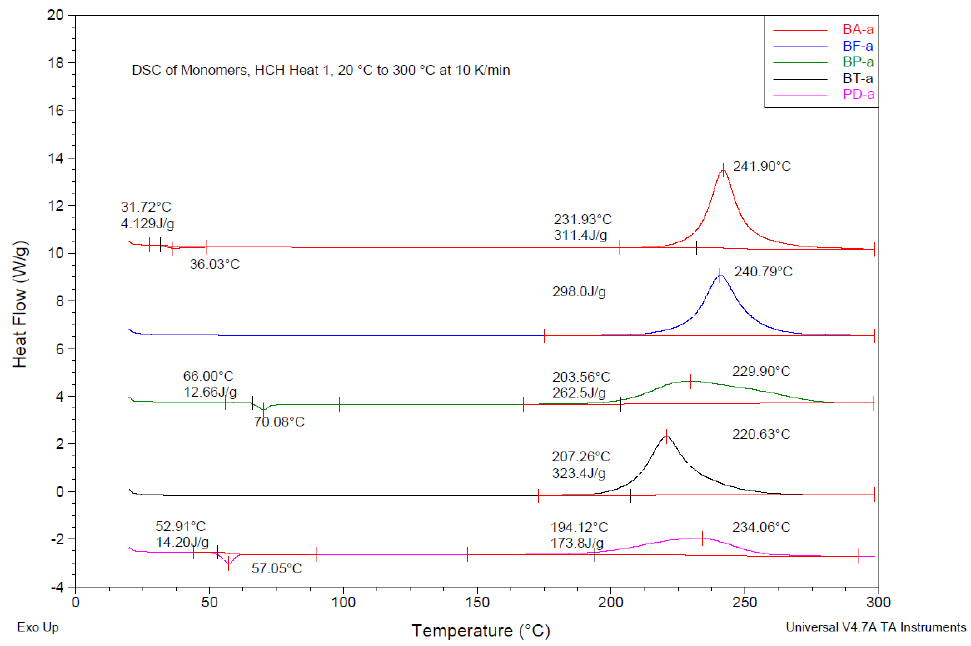
Figure 2. DSC of monomers, first heat of a heat cool heat cycle at 10 K/min.